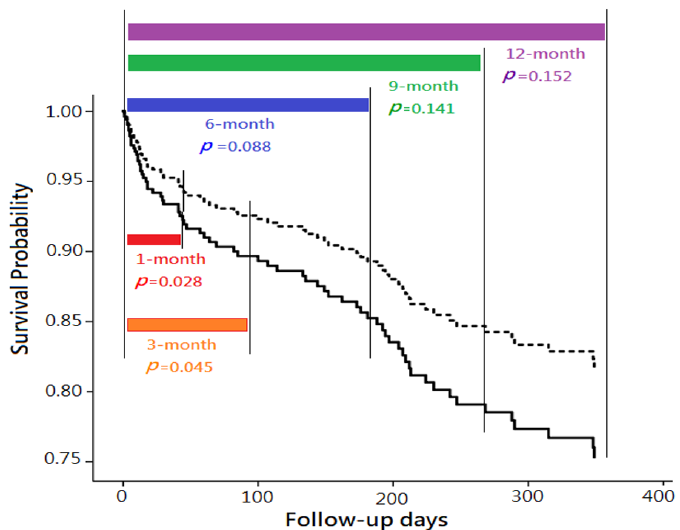
Figure 3. Comparison of mortality with various follow-up periods, between two groups categorized by plasma N-terminal pro-brain natriuretic peptide (NT-proBNP) levels, with risk factor adjustment. Note: The comparisons were performed using multivariate Cox proportional hazard regression models. The survival differences of between the patients with plasma NT-proBNP ≧ 11,755 ng/L (solid line) and those with plasma NT-proBNP <11,755 ng/L (dashed line) were only observed in 1-month ( p = 0.028) and 3-month follow-up ( p = 0.045), but not found in longer follow-up (including 6-month, 9-month, and 12-month